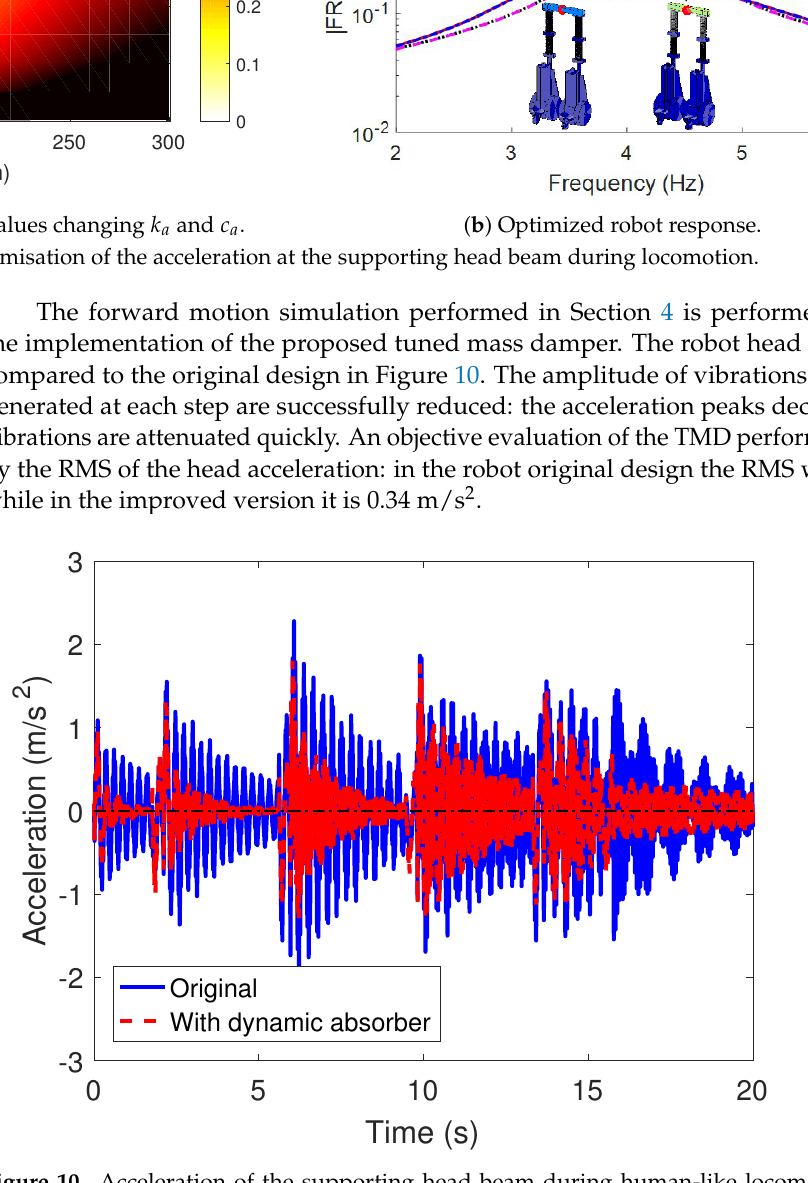
Figure 10. Acceleration of the supporting head beam during human-like locomotion using the dynamic